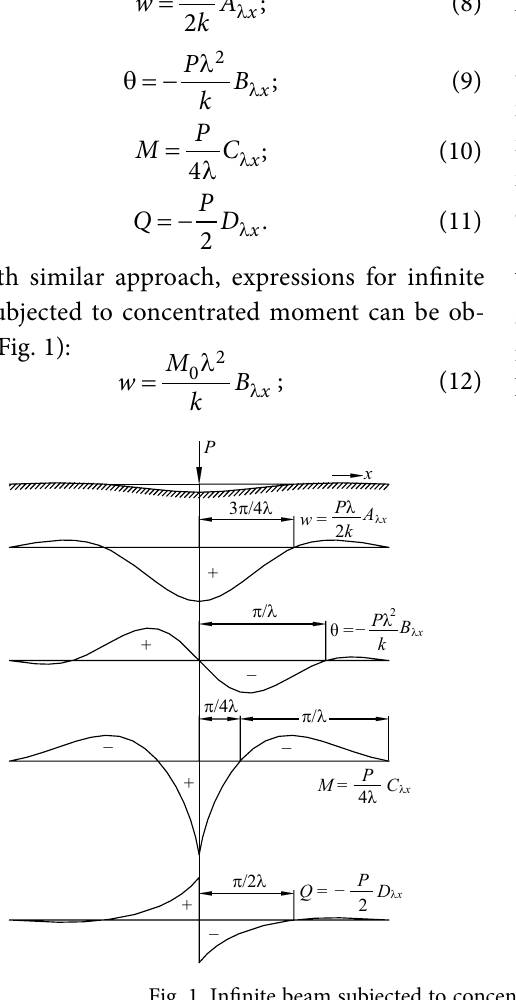
Fig. 1. Infinite beam subjected to concentrated load (left) and moment